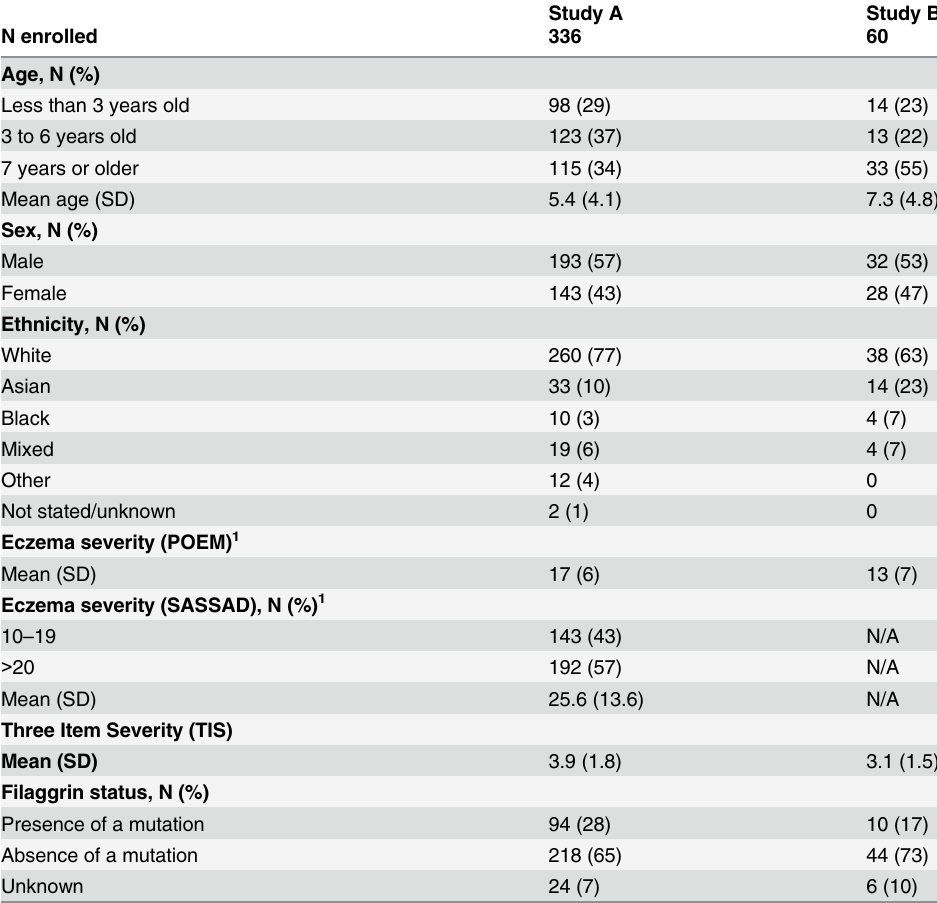
Table 1. Baseline characteristics of included